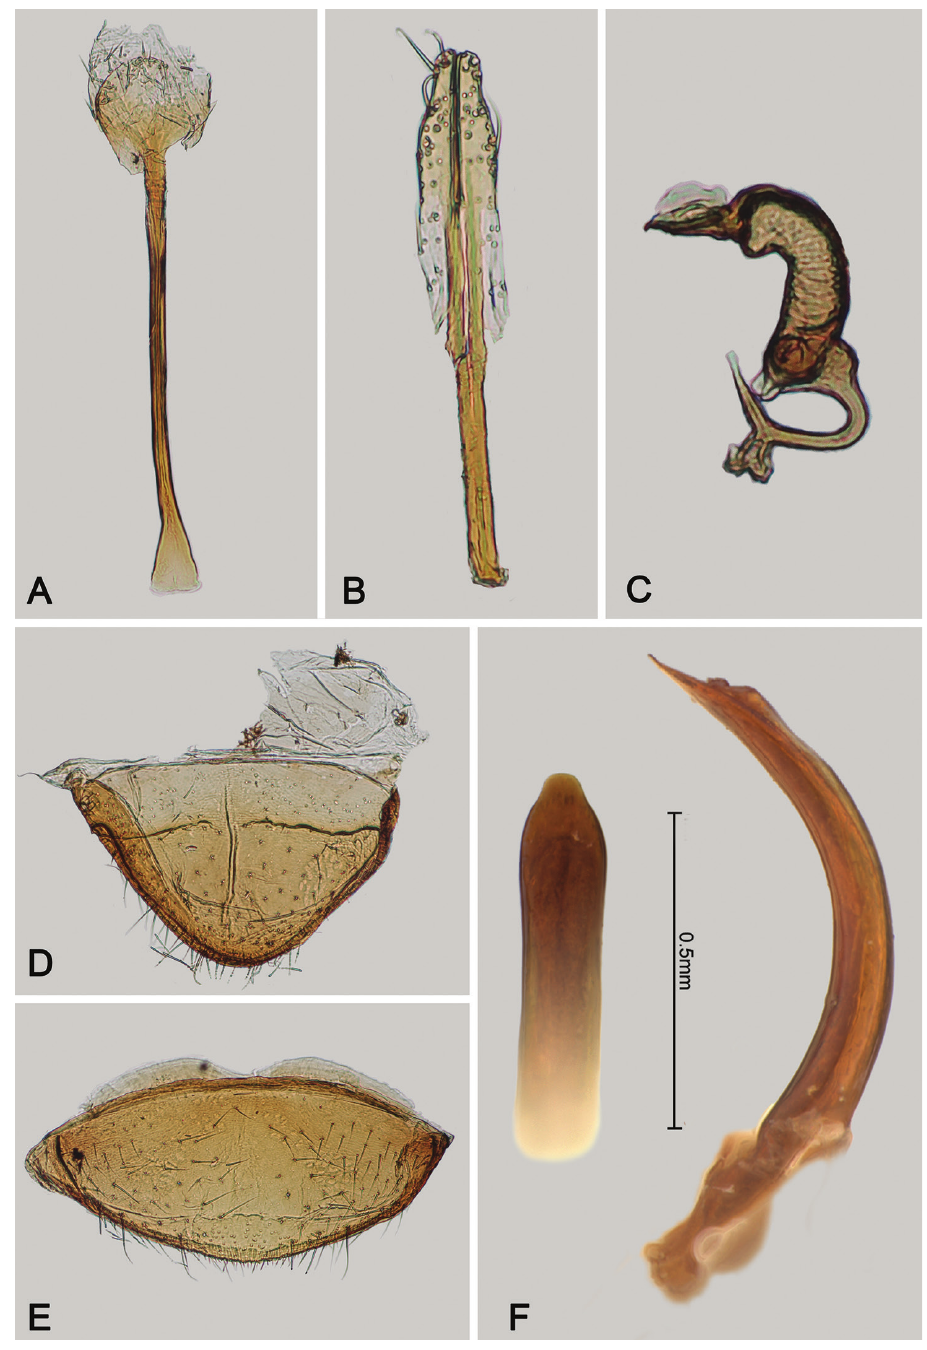
Figure 13. Andersonoplatus jolyi . A Tignum B Vaginal palpi C Spermatheca D Last abdominal tergite of female E Last abdominal sternite of female F Median lobe of aedeagus, ventral and lateral